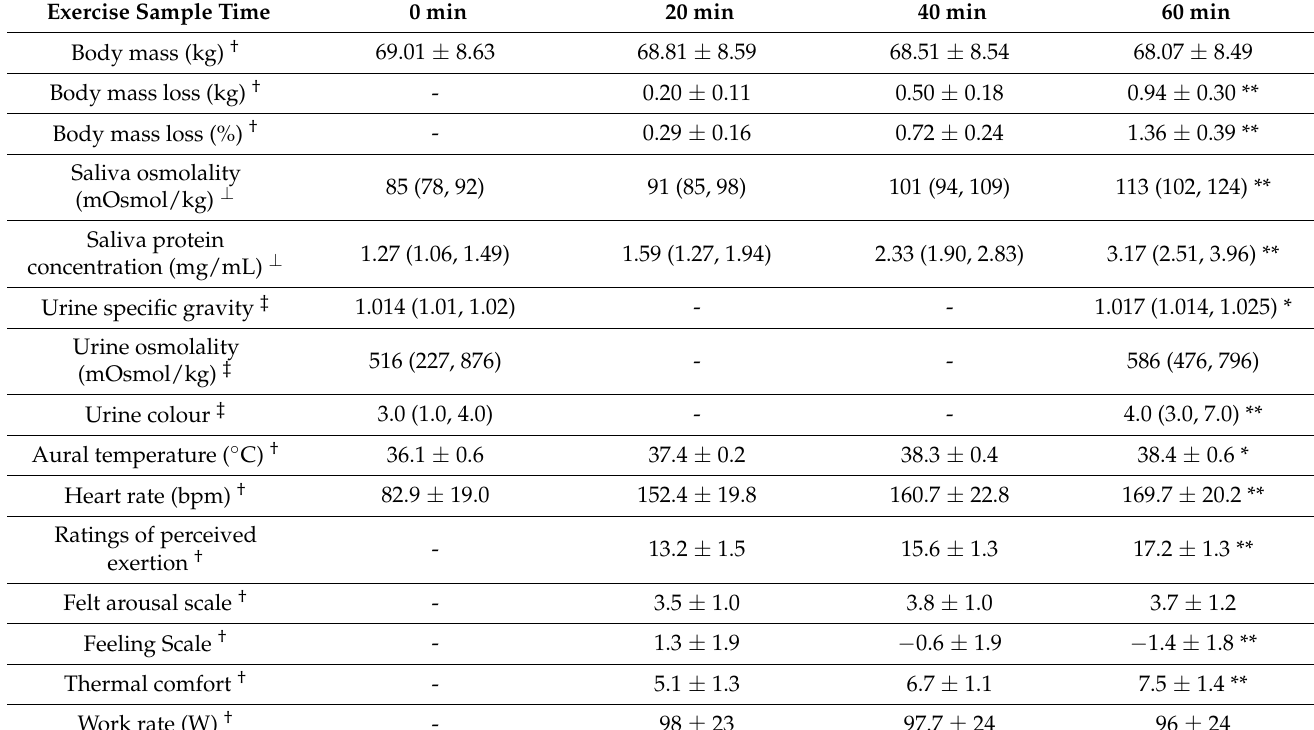
Table 2. Physiological and perceptual responses throughout exercise. † Values are means ± SD. ⊥ Values are geometric means (95% CI). ‡ Values are medians (25, 75 percentiles). * Significant change at 60 min ( p < 0.05). ** Significant change at 60 min ( p <